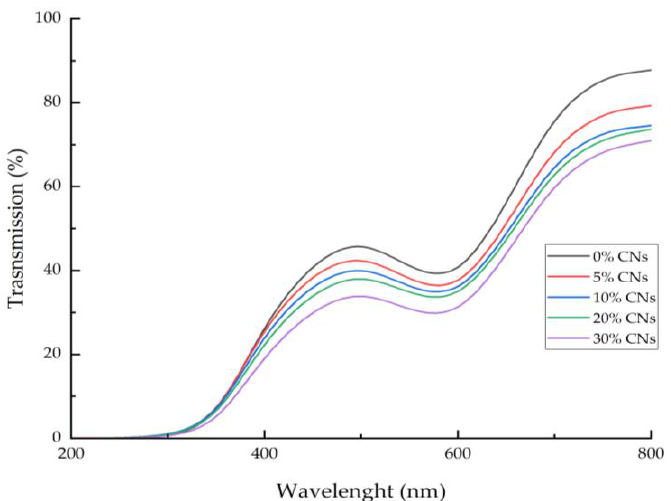
Values are given as mean ± SD, n = 3. Different superscripts in each column are significantly different ( p < 0.05).